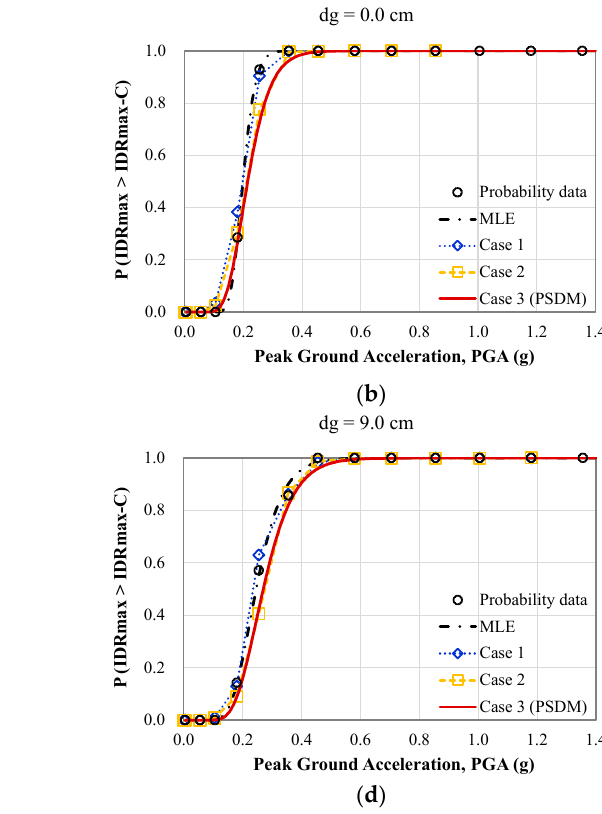
Figure 12. Influence of the PSDM assumptions on the fragility assessment of the eight-story RC frame in terms of IDR max (%h st ) as a function of the PGA. Examined assumptions: Case 1—lognormality, Case 2—lognormality and power law model, and Case 3—SDM’s assumptions. Fragility curves ( a ) without the pounding effect, ( b ) d g = 0.0 cm, ( c ) d g = 4.5 cm, and ( d ) d g = 9.0 cm.